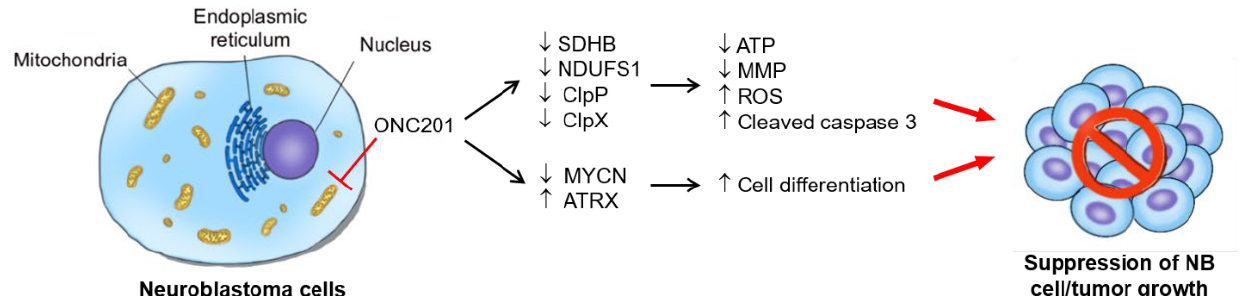
Figure 7. The proposed working model for interruption of mitochondrial functions, induced apoptosis, and differentiation in NB cells: ONC201 treatment targets mitochondria to perturb mitochondrial functions, e.g., the treatment disrupts the mitochondrial ClpXP complex, impairs respiratory chain activity, and leads to mitochondrial function loss and ROS accumulation. The enhancement of ROS production finally induces apoptosis in NB cells. In addition to cell death, ONC201 treatment also promotes the nuclear expression of ATRX, which supports neuronal differentiation and the suppression of NB growth.